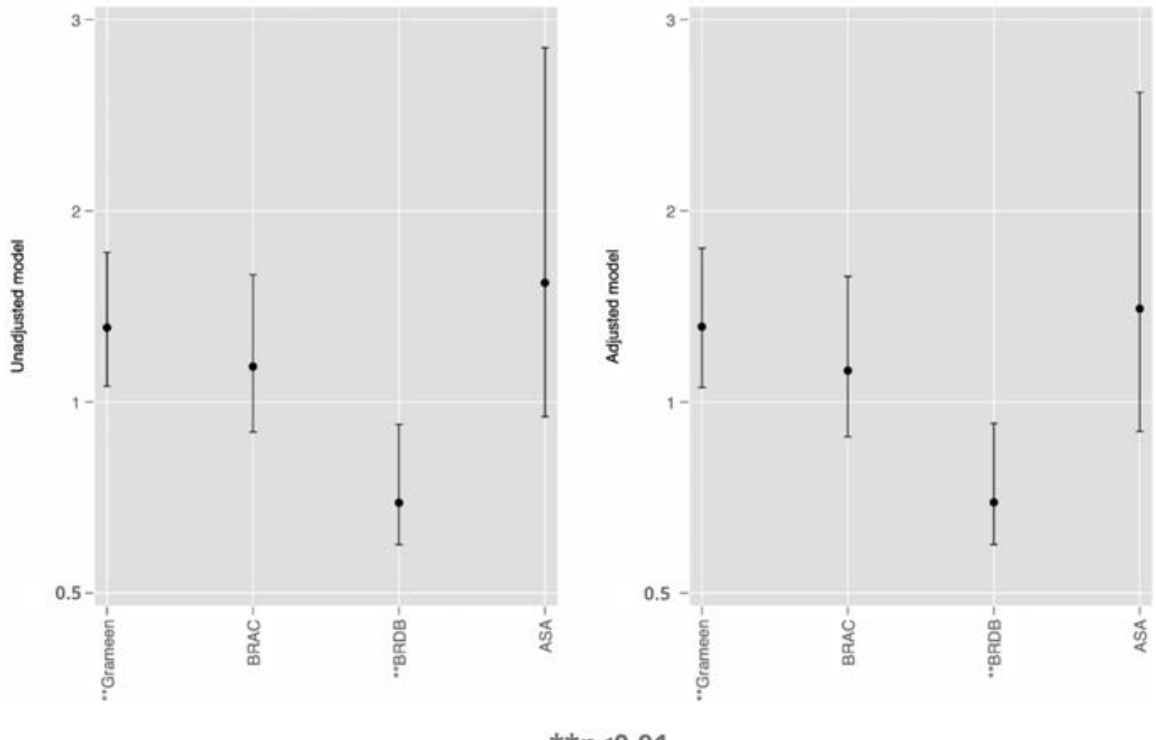
Figure 3. Association between MC membership and health autonomy (BDHS 2014).[21]